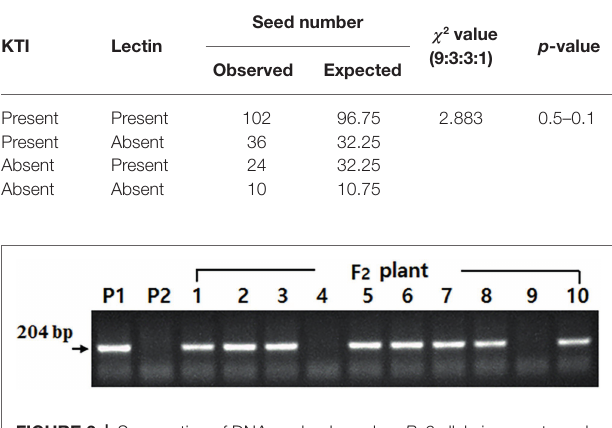
FIGURE 3 | Segregation of DNA marker based on Rs2 allele in parents and 10 F 2 individual plants with the tetra null genotype ( lox1lox2lox3 / lox1lox2lox3 - ti / ti - le / le - cgy1 / cgy1 ). P1: lox1lox2lox3/lox1lox2lox3 - ti/ti - le/le - cgy1/cgy1 - Rs2/ Rs2 genotype. P2: lox1lox2lox3/lox1lox2lox3 - Ti/Ti - Le/Le - cgy1/cgy1 - rs2/rs2 genotype. F 2 plant—4 and 9; rs2rs2